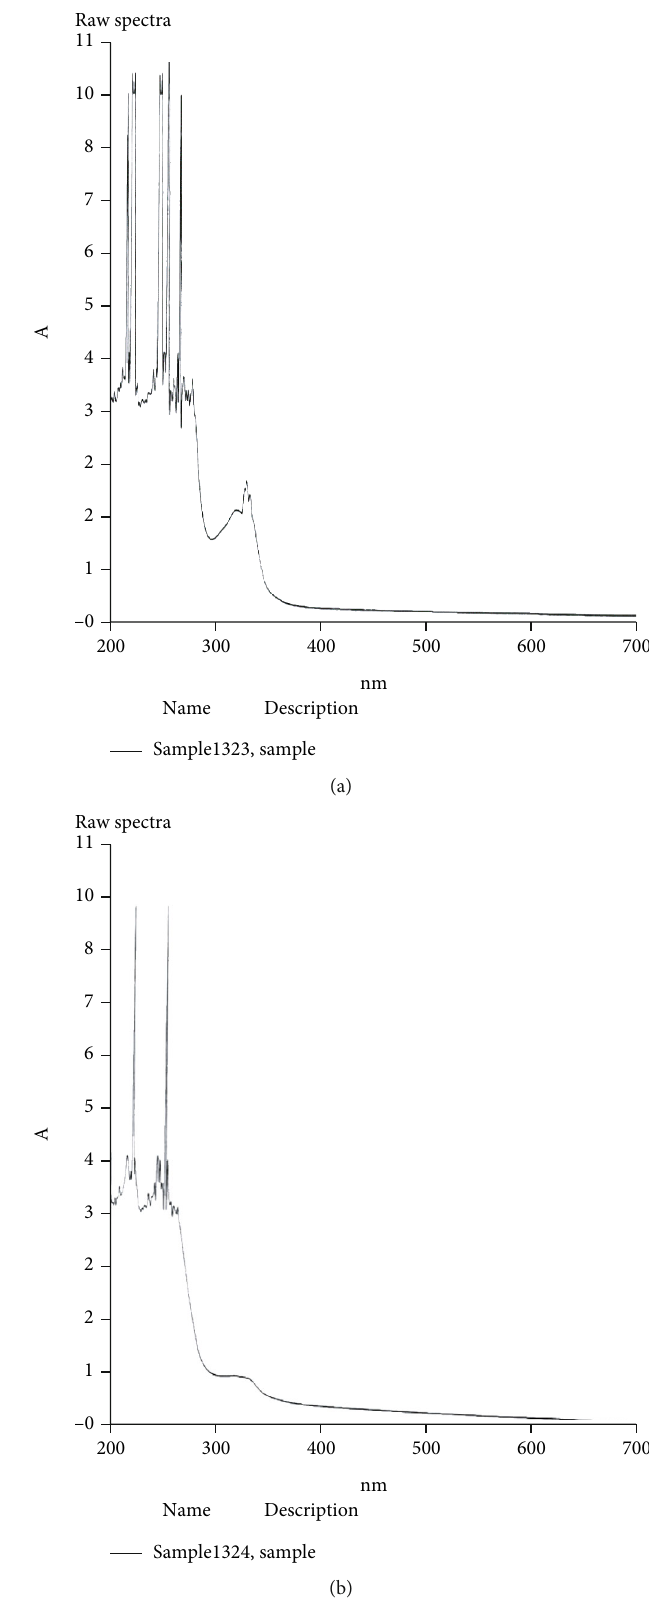
Figure 9: Spectrophotometer analysis of wastewater before (a) and after treatment (b) with the UV/Fe-Z5A/O3 process ( spiked C o ð = 50mg/L ; COD = 104mg/L ; pH = 7 : 2 ± 0 : 2 ; O cipro Þ